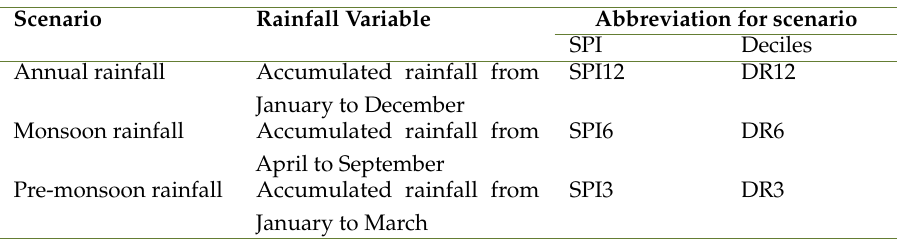
Table 4. Scenarios of rainfall for computation of standard precipitation index and deciles.